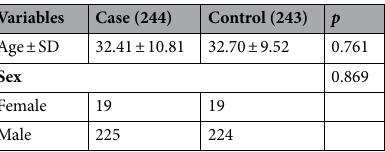
Table 1. Characteristics of participants. p < 0.05 indicates statistical